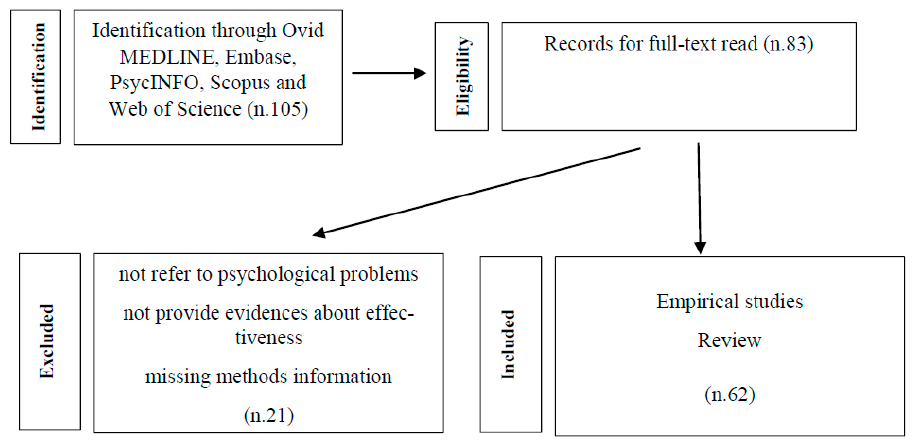
Figure 1. Selection of studies flowchart.